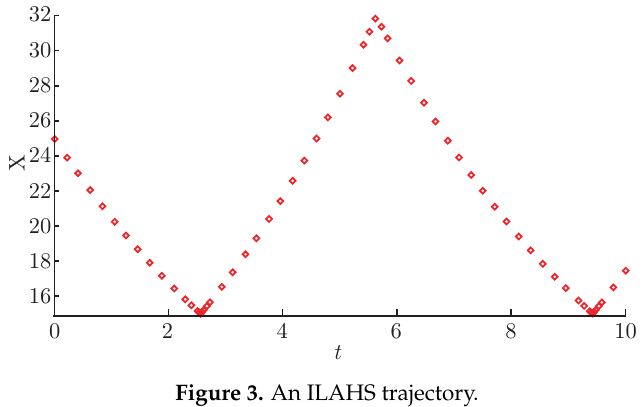
Figure 3. An ILAHS trajectory. Fig. 1: A thermostat